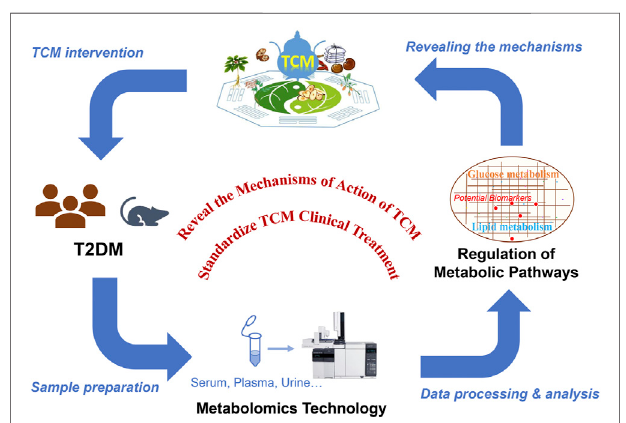
FIGURE 2 | Metabolomics reveals the mechanisms underlying the ef fi cacy of TCM for treating T2DM.